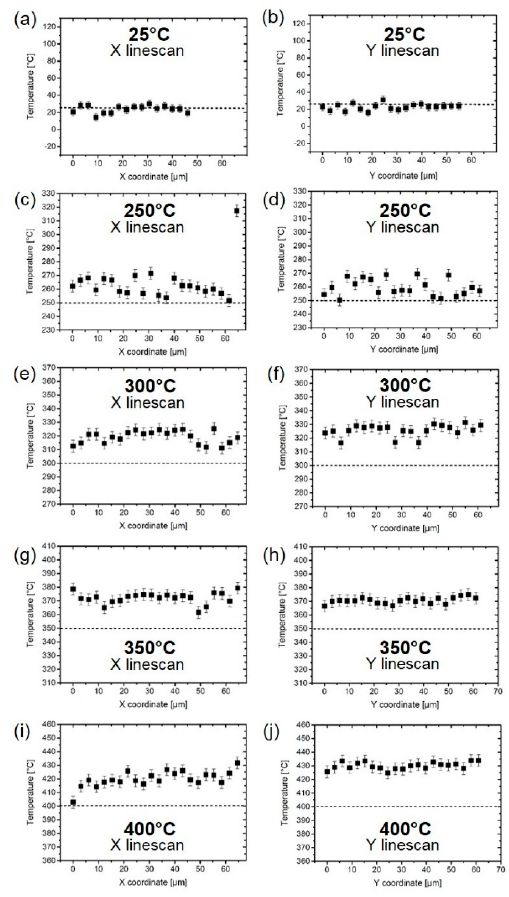
Figure 5. Temperatures measured on the surface of Si µhps at different set temperatures and in X and Y directions. ( a,b ) 25 °C, X and Y; ( c,d ) 250 °C, X and Y; ( e,f ), 300 °C, X and Y; ( g,h ) 350 °C, X and Y; ( i,j ), 400 °C, X and Y. The line scans at 25 °C were interrupted earlier. Note the increasing discrepancy between set and measured temperatures for increasing T.